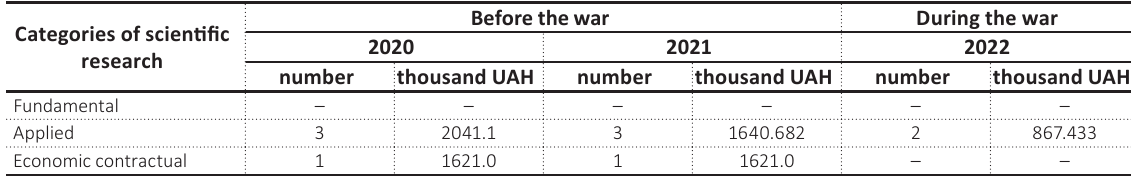
Table A3. Amount of R&D funding in 2020–2022 (number of research projects and amount of funding, thousand